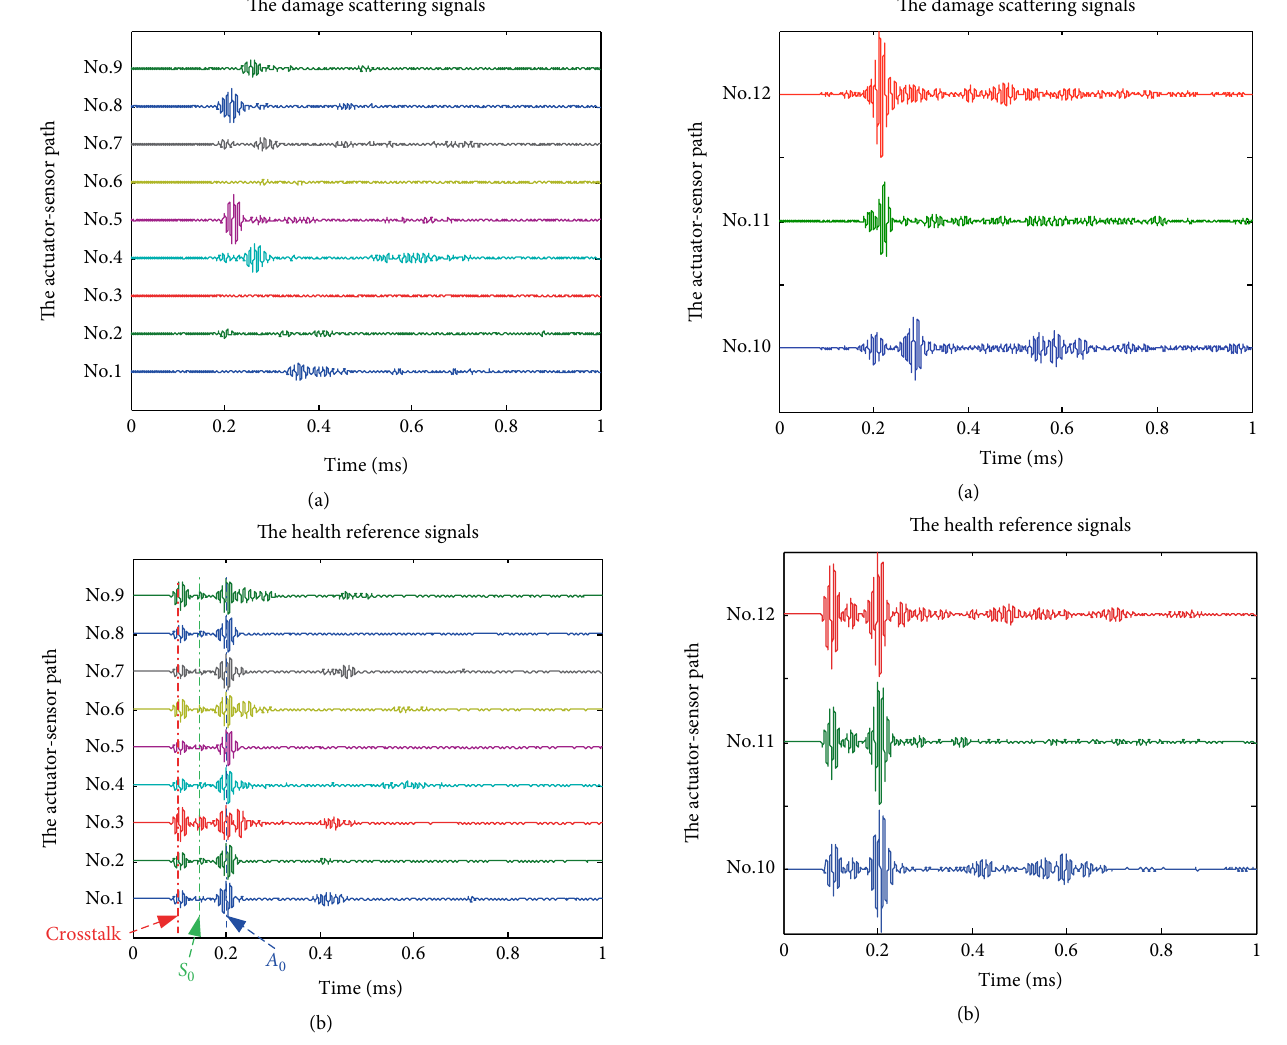
Figure 10: The damage scattering and health reference signals of the other diagonal in the suspected damage subareas. (a) The damage scattering signals; (b) the health reference Table 2: The damage indexes of the diagonal actuator-sensor path of each subarea.